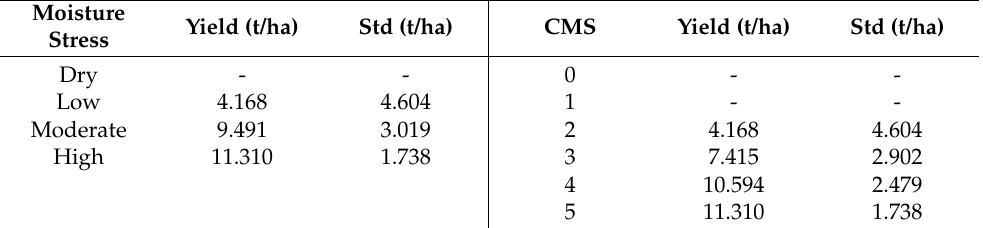
Figure 4. Time series of NDMI values at sunflower parcels in four growing seasons: 2020 ( A ), 2019 ( B ), 2018 ( C ), and 2017 ( D ). Table 1. Comparison between moisture stress in July and CMS for maize yields.